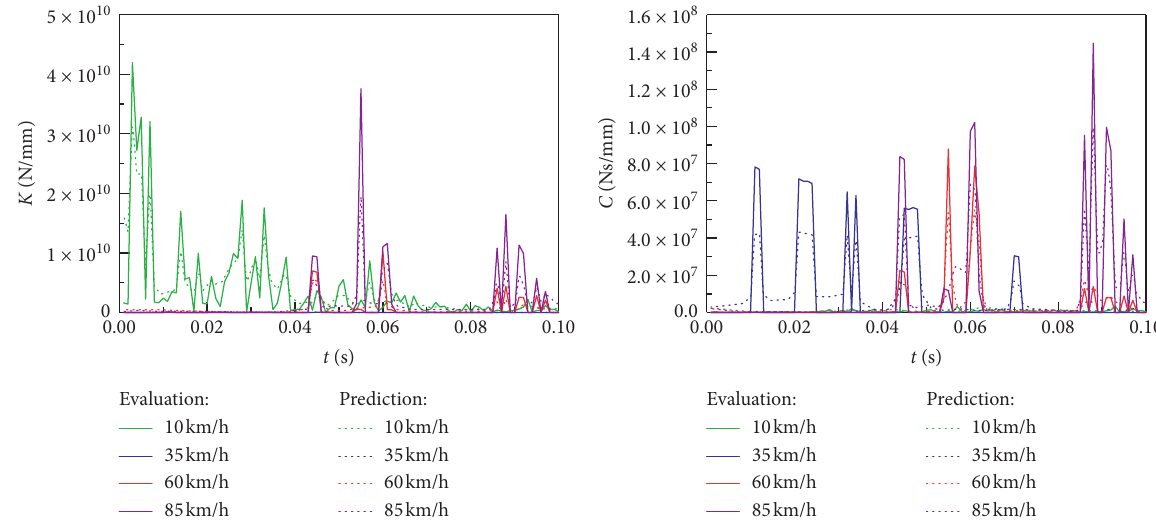
Figure 10: Coupler buffer device 4 comparisons of estimation and